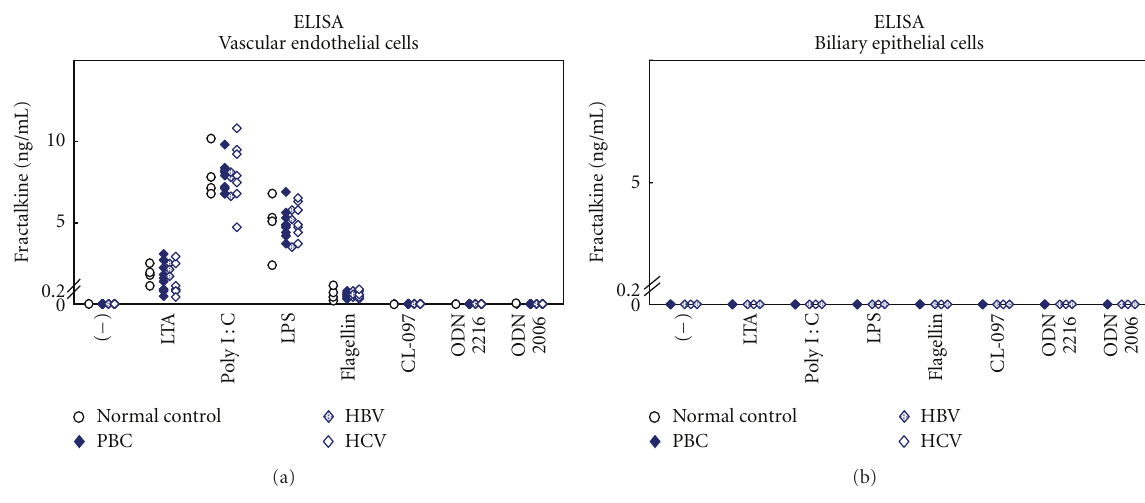
Figure 2: (a) Fractalkine production from endothelial cells from PBC and control (chronic hepatitis B and C) livers exposed to TLR ligands. Endothelial cells produced fractalkine with LTA, poly I :C, LPS, and flagellin with no significant di ff erences observed between patients and control livers. (b) BEC did not produce fractalkine with any additional TLR